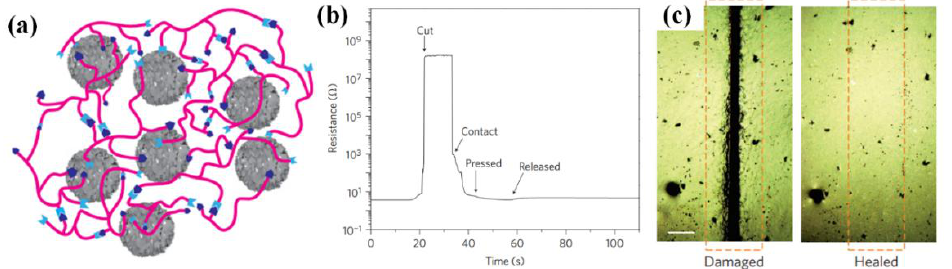
Figure 12. The tactile sensor with self-healing ability: ( a ) The interaction of oligomer chains with μNi particles; ( b ) The electrical healing process of resistance for 15 s healing time at room temperature; ( c ) Optical image of damaged sample and complete scar healing. Adapted with permission from [198], Copyright (2012) Nature.